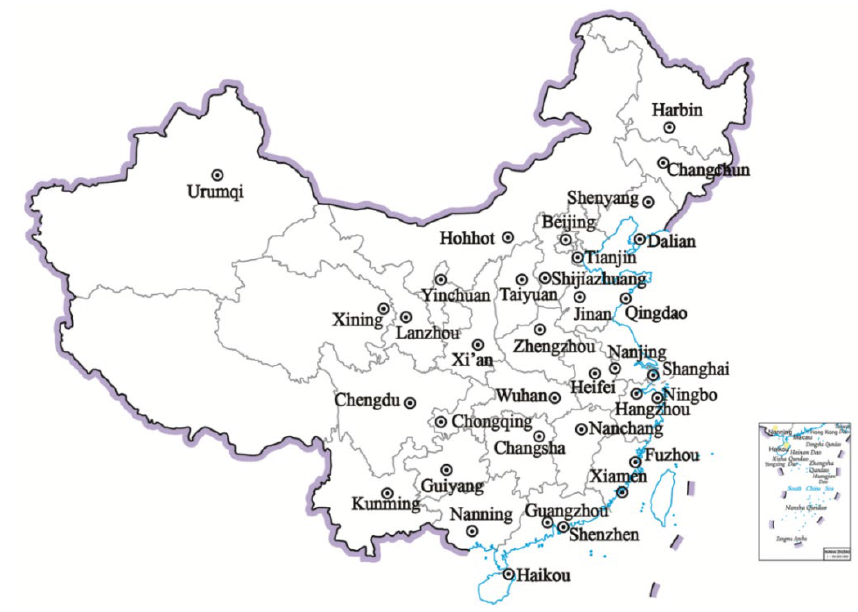
Figure 3. Spatial distribution of 35 sample cities.